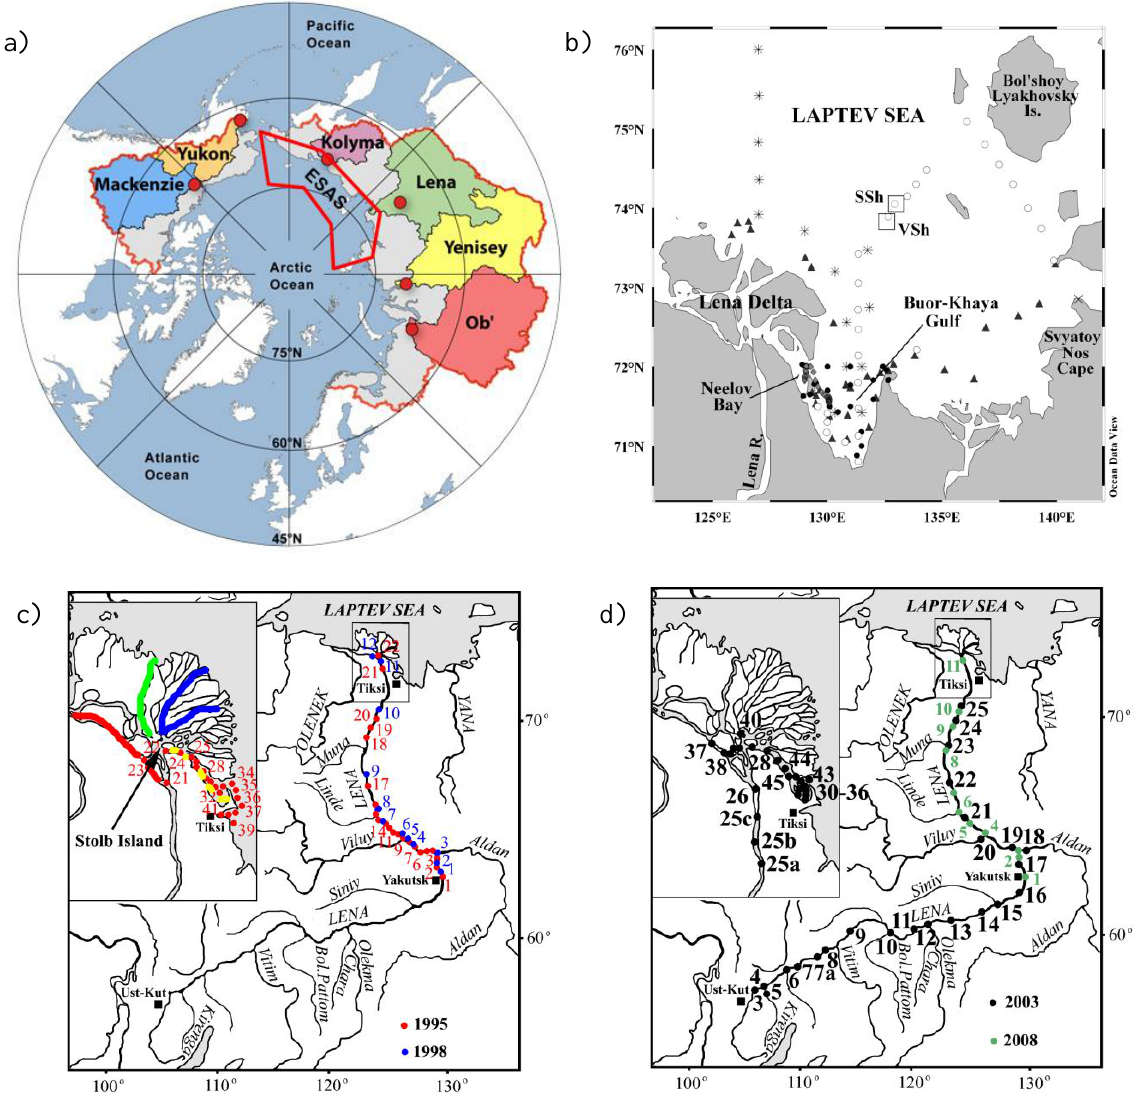
Fig. 1. Map of the study area location: (a) watersheds of the six largest arctic rivers and the ESAS position (modified from http: //arcticgreatrivers.org/ ); (b) the Laptev Sea stations, Dunay , September 1997; (cid:13) Auga , September 2005; ♦ Neptun and * Kapitan Danilkin , September 2006; • Winter expedition , April 2002; SSh – Semenovskaya Shoal; VSh – Vasilievskaya Shoal; (c) the Lena River stations, late August–early September 1995 and September 1998; (d) the Lena River stations, September 2003 and 2008. Location of major channels is marked by yellow (Bykovskaya Channel), blue (Malya and Bol’shaya Trofimofskaya channels), green (Tumatskaya Channel), and red (Olenekskaya